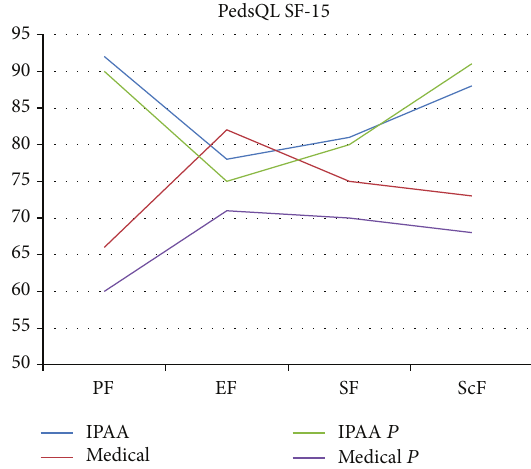
Figure 3: PedsQL-SF-15 scores of IPAA and medical patients. Each dimension of the questionnaire is reported separately. Several significant differences were observed. Overall QoL-IPAA versus medical, 0.84 versus 0.74 ( 𝑃 = 0.04 ); SF-IPAA versus medical, 0.92 versus 0.68 ( 𝑃 = 0.02 ); ScF-IPAA versus medical, 0.88 versus 0.72 ( 𝑃 = 0.04 ); overall QoL-medical versus medicalp, 0.72 versus 0.67 ( 𝑃 = 0.04 ). PF: physical function; EF: emotional function; SF: social function; ScF: school function; IPAA: ileal pouch-anal